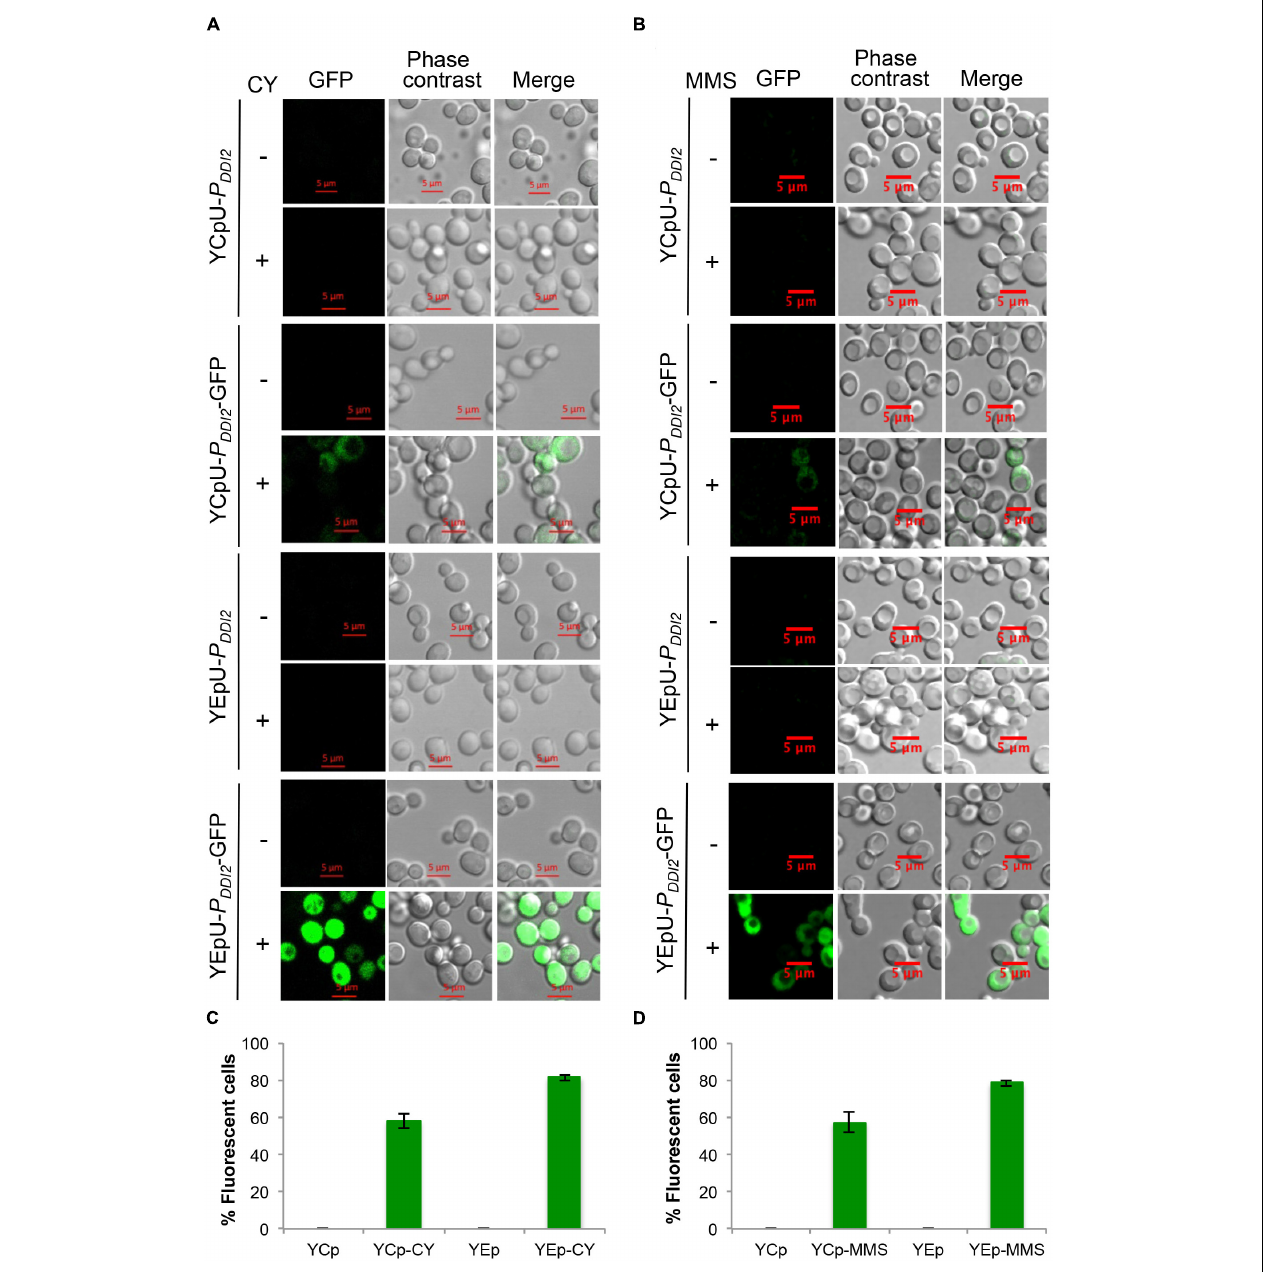
FIGURE 5 | Fluorescent microscopic analysis of BY4741 transformants harboring P DDI2 -GFP plasmids. (A) Representative images of cells with or without 20 mM CY treatment for 2 h. (B) Representative images of cells with or without 0.015% MMS treatment for 2 h. Plasmids are indicated on the left panel. (C,D) Quantitative analysis of percentage of fluorescent cells as shown in (A,B) , respectively. Cells transformed with empty vectors without the GFP gene are all negative for fluorescence and the data are not shown in the